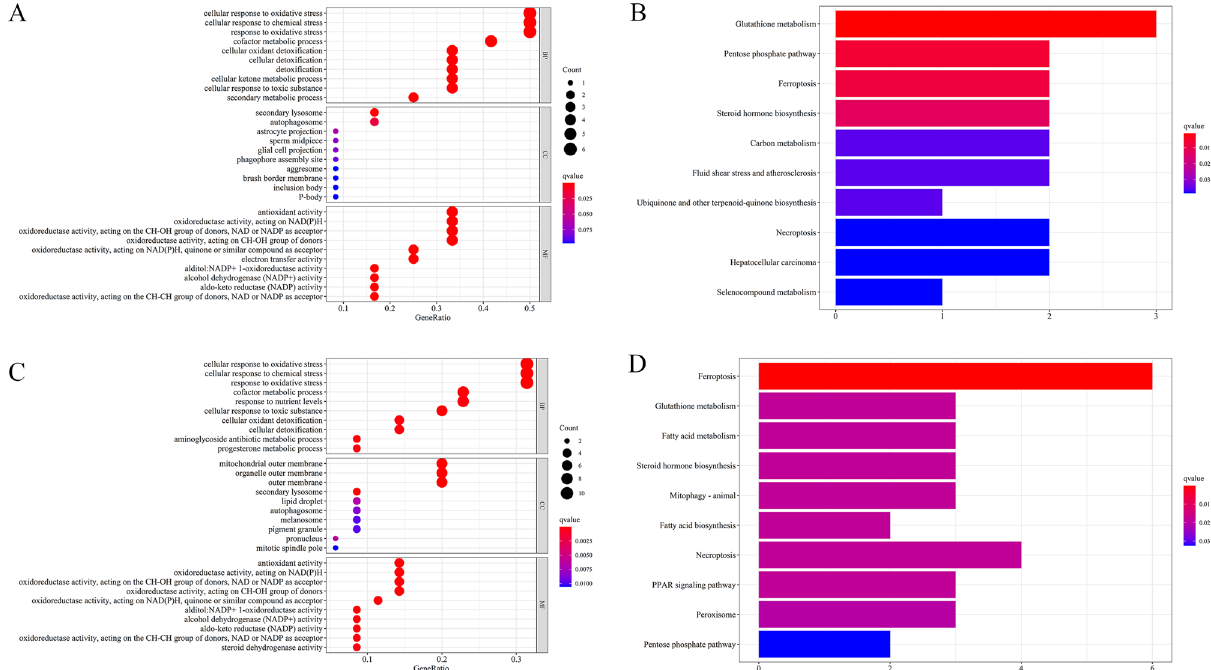
Figure 7. Gene Ontology (GO) and Kyoto Encyclopedia of Genes (KEGG) enrichment analysis in training and validation cohorts. ( A,C ) GO analysis based on prognostic ferroptosis-related genes in TCGA ( A ) and ICGC